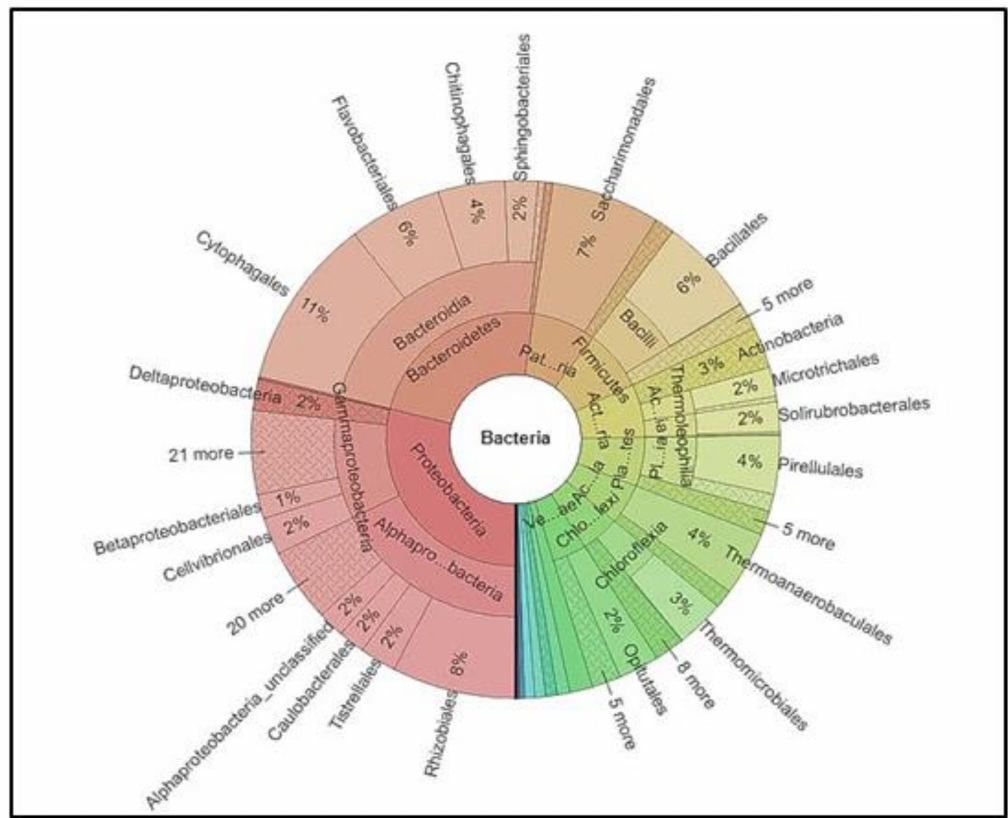
Figure 9. A Krona chart representing the distribution of the whole bacterial community in compost sample B.